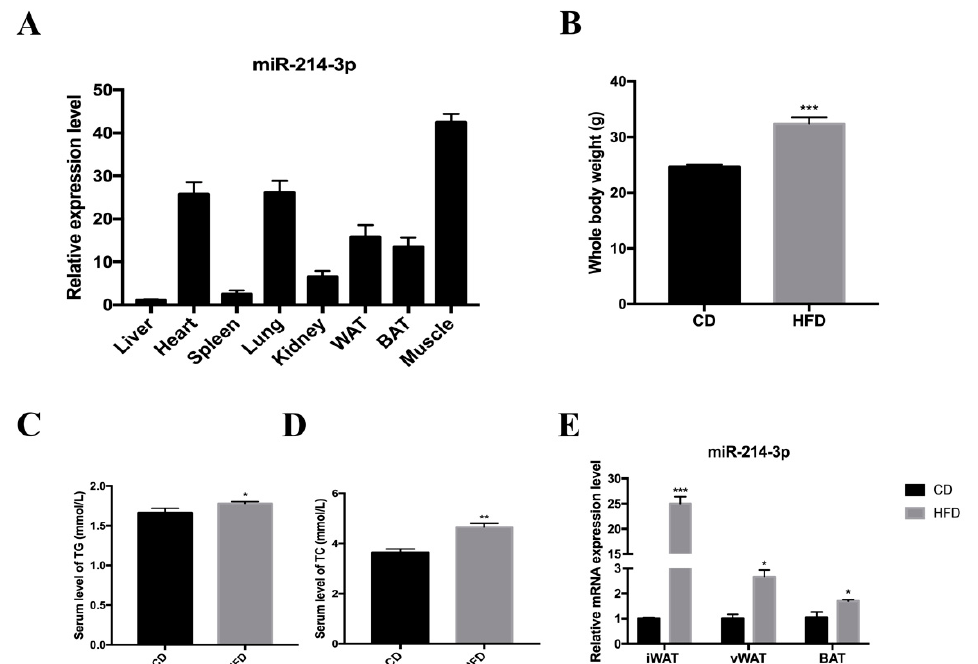
Figure 1. The expression of miR-214-3p is high in adipose tissue. ( A ) The relative expression level of miR-214-3p in eight different tissues of C57BL/6J mice vs. liver; ( B ) C57BL/6J mice were weighed after 12 weeks of being fed a high fat diet (HFD) or chow diet (CD); ( C ) the serum level of total triglyceride (TG); and ( D ) cholesterol (TC) were measured; ( E ) The expression of miR-214-3p in inguinal white adipose tissue (iWAT), perigonadal visceral adipose tissues (vWAT), and interscapular brown adipose tissue (BAT). Results were indicated as the mean ± SEM, n = 5. * p < 0.05; ** p < 0.01, *** p < 0.001.